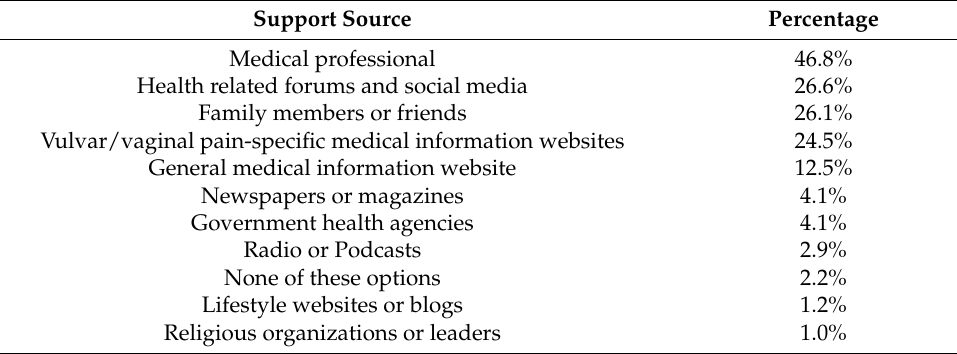
Table 1. Percentages for most helpful emotional support sources.